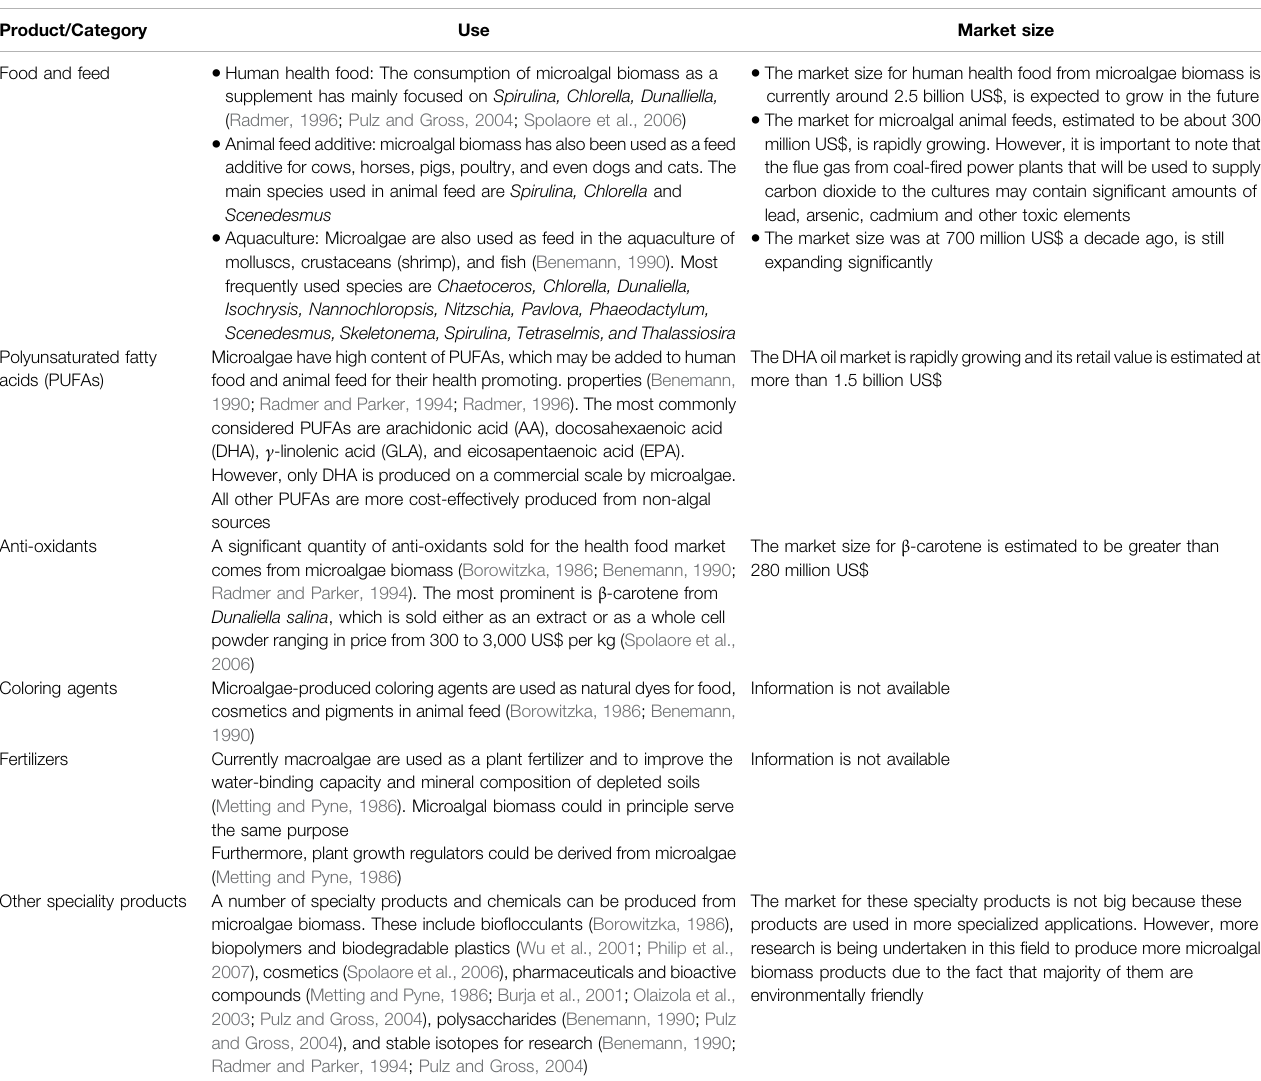
TABLE 3 | Category of microalgae products, use and market